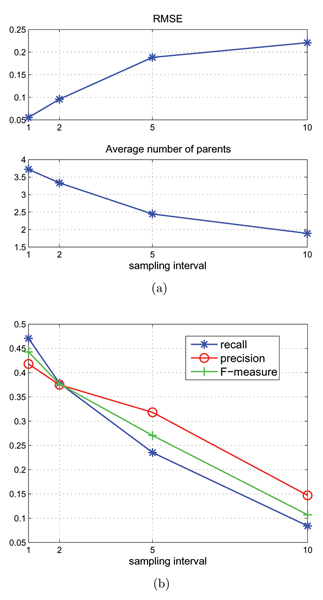
Robustness of the linear model when varying the sampling interval. Plots of the RMSE and average number of parents (a), and recall, precision and F-measures (b) of the linear model, as a function of the sampling interval s (in minutes).